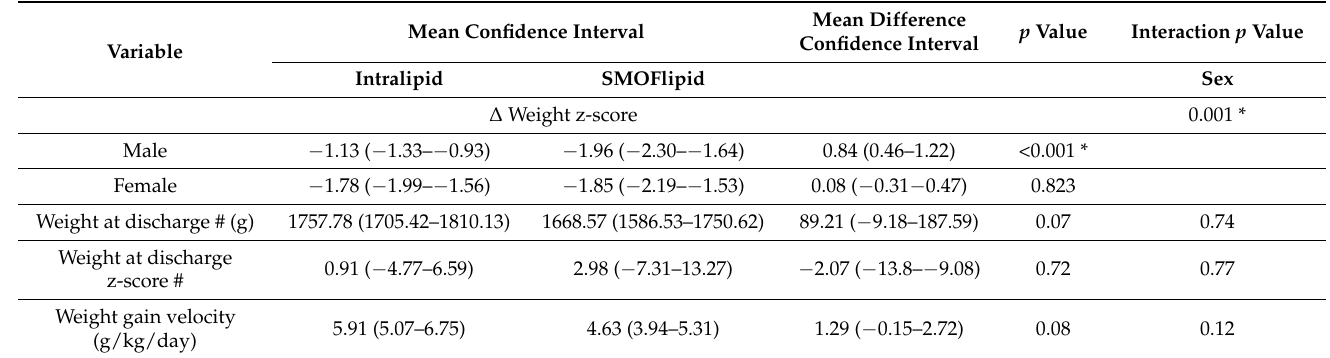
Table 5. Effect of SMOFlipid on neonatal growth profile at 36 weeks or